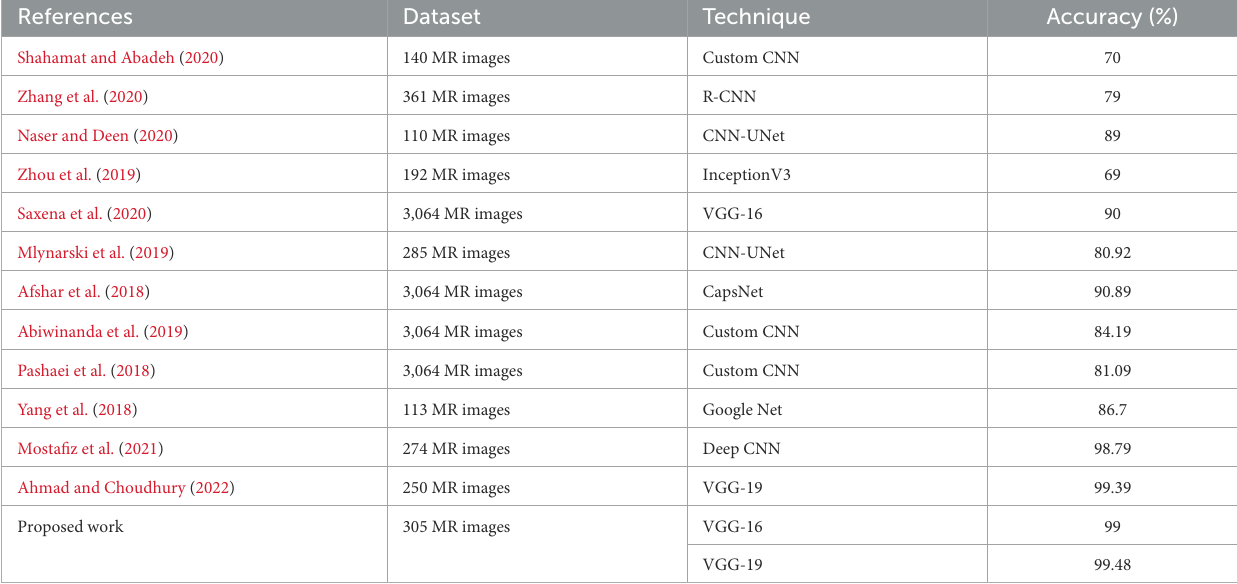
TABLE 5 Comparison of the study’s findings with existing